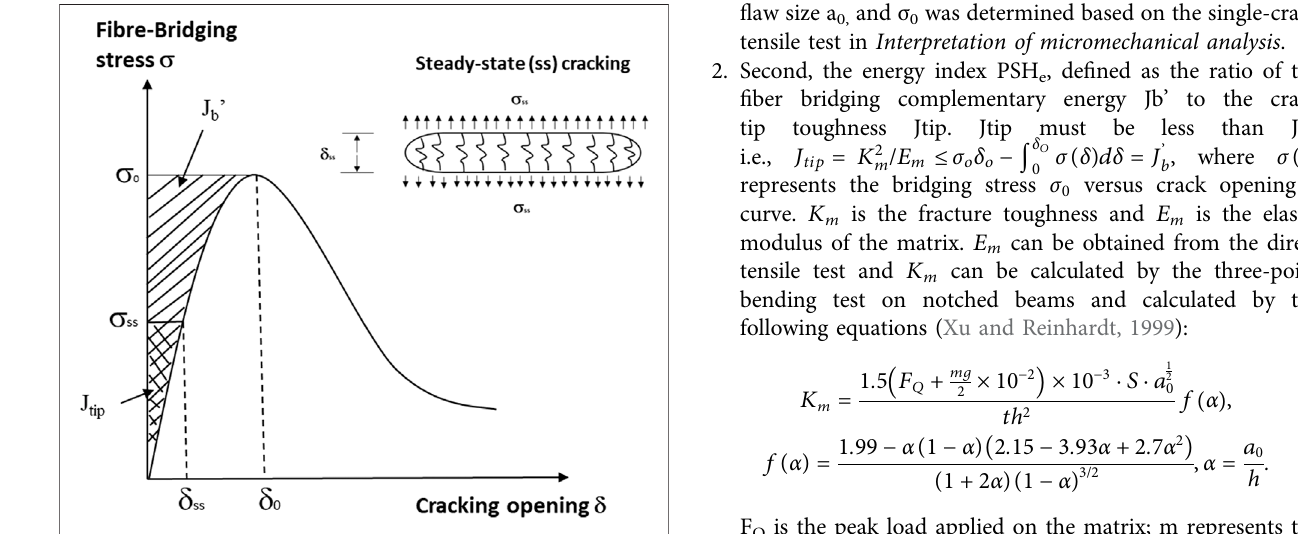
FIGURE 1 | Typical relationship curve of